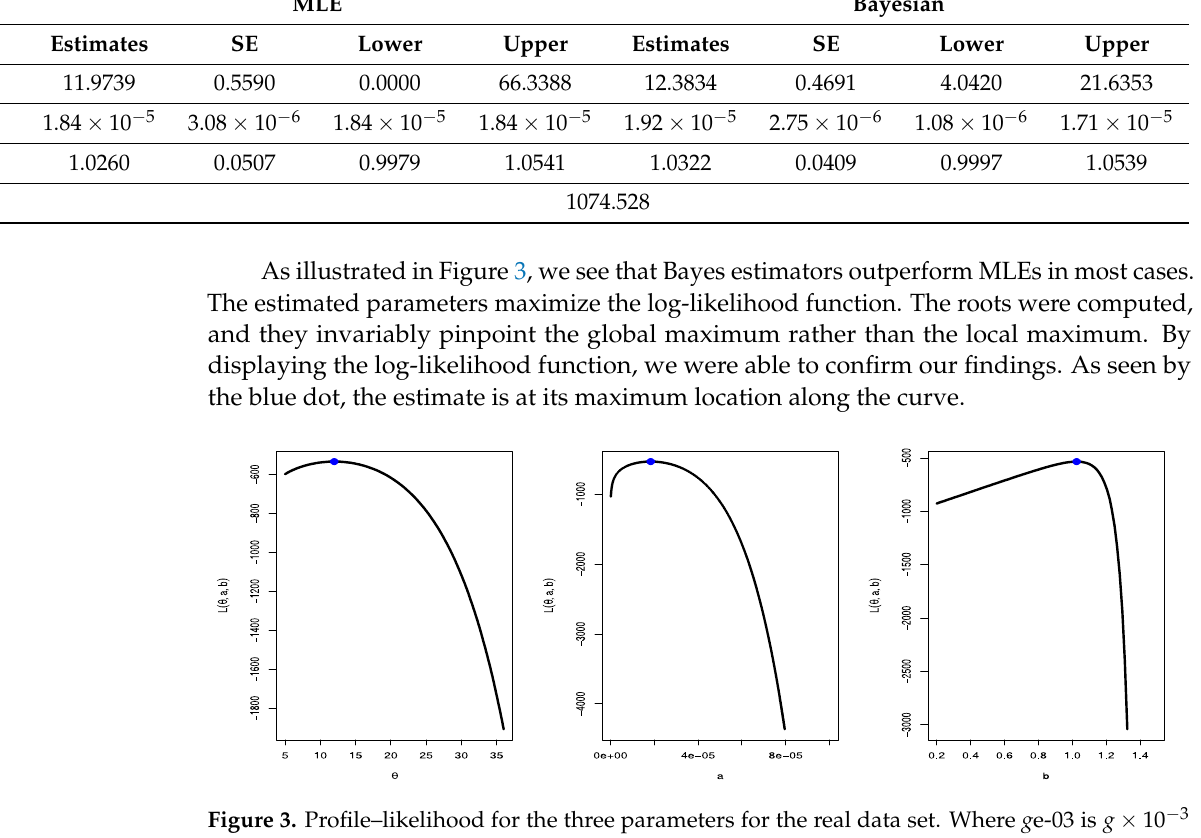
Table 8. MLEs and Bayesian estimates for parameters of progressive-stress model. MLE